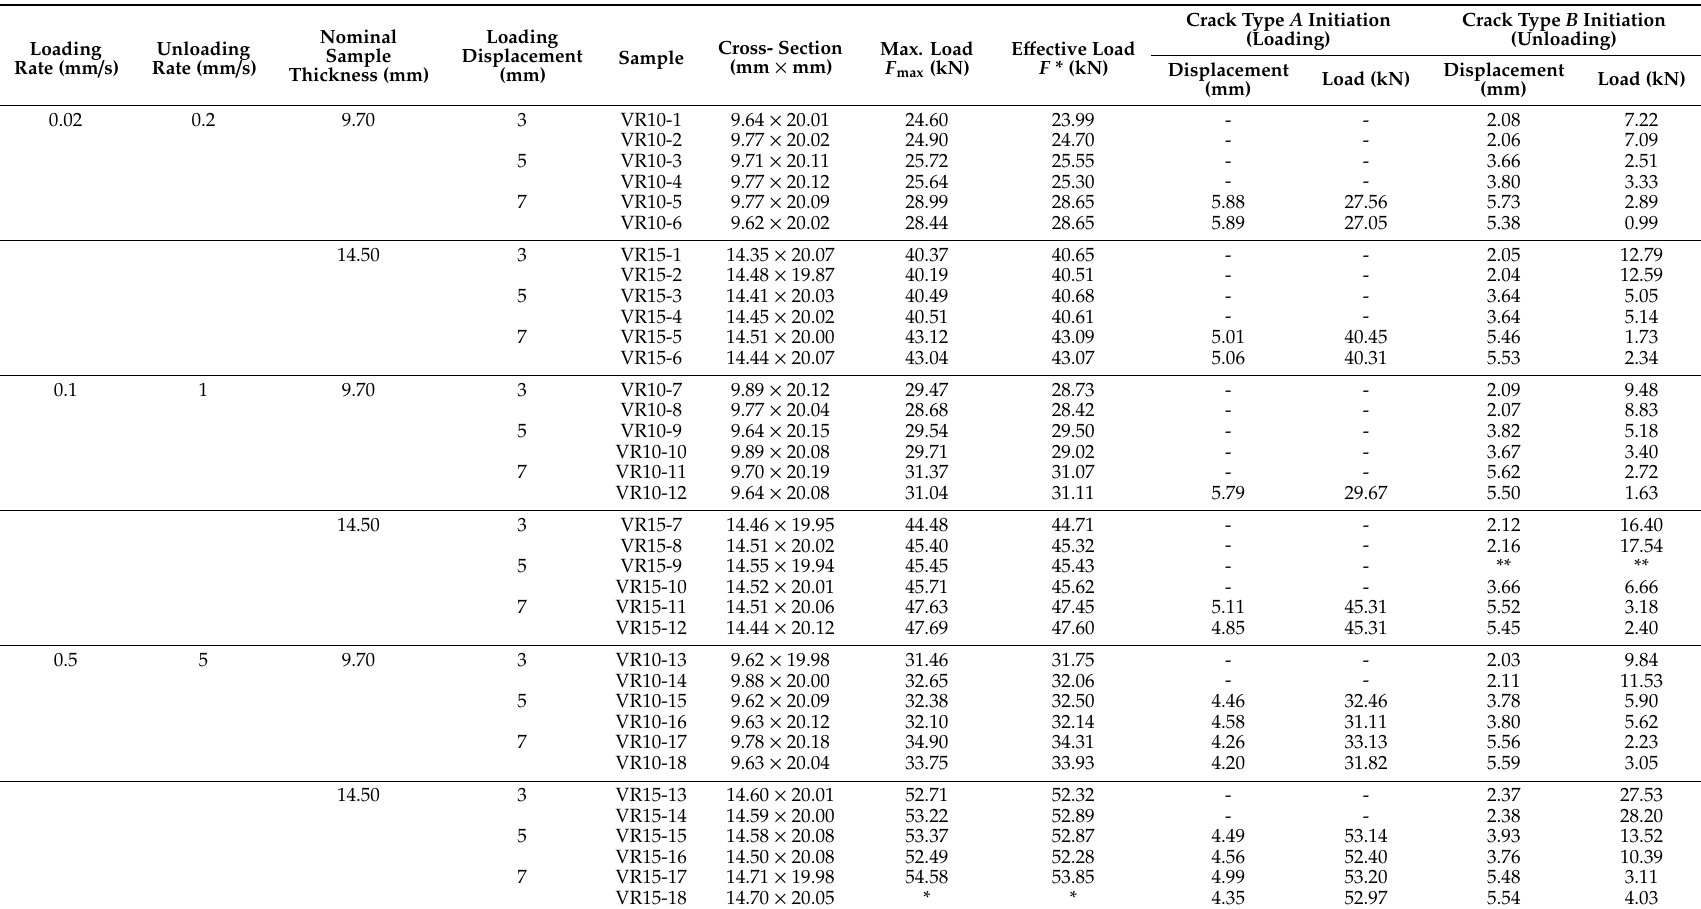
Table A3. Fracture load and displacement for the samples with rounded